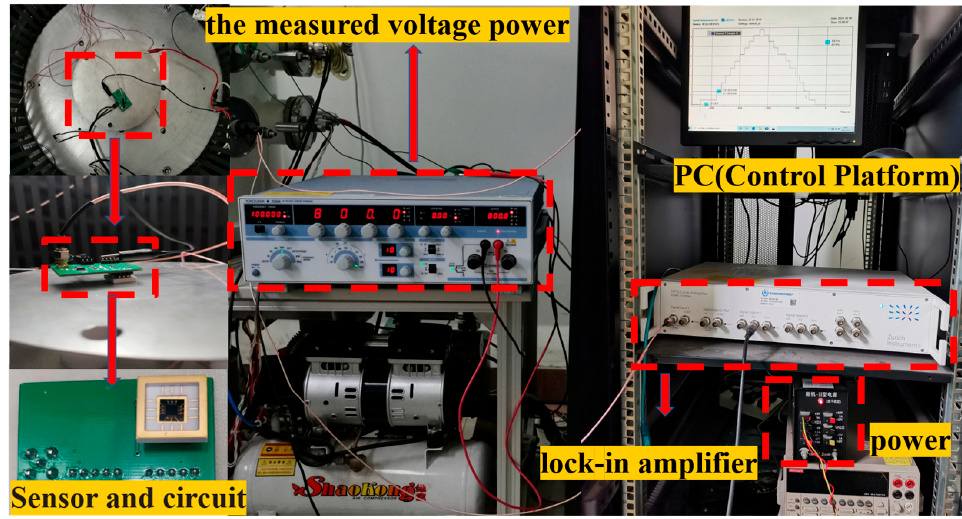
Figure 10. Photo of the experimental setup.